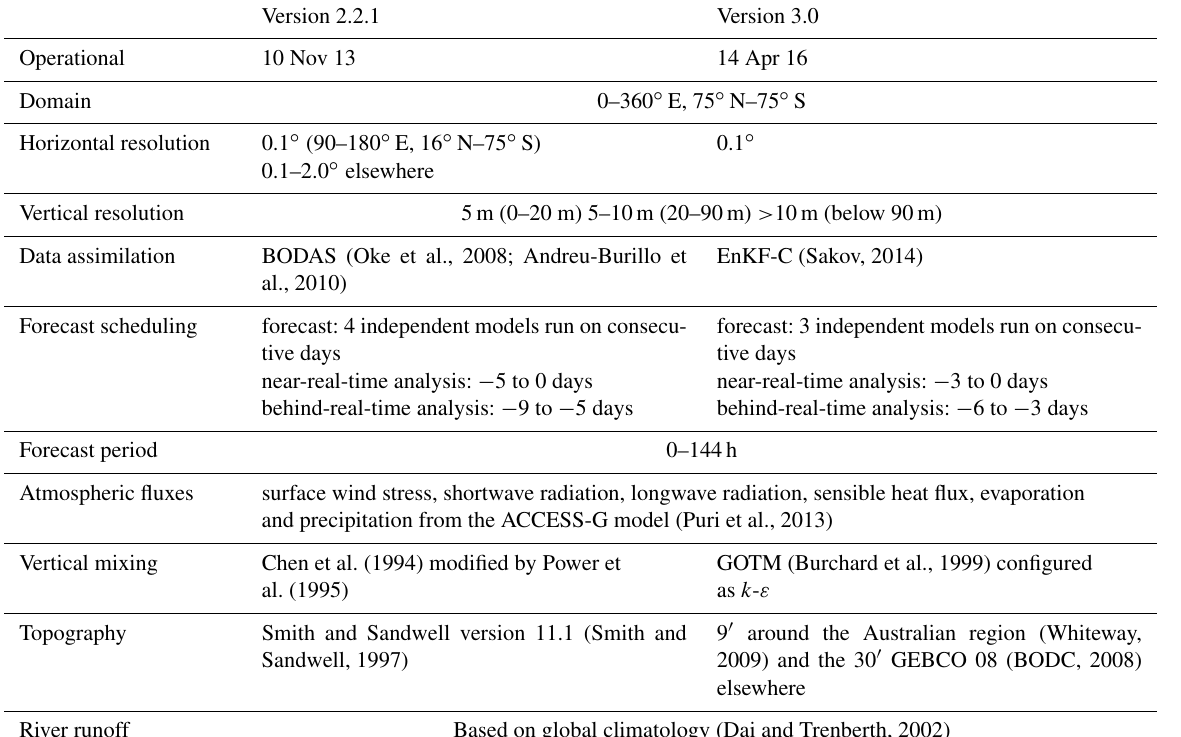
Table 1. Details of the OceanMAPS versions compared in this